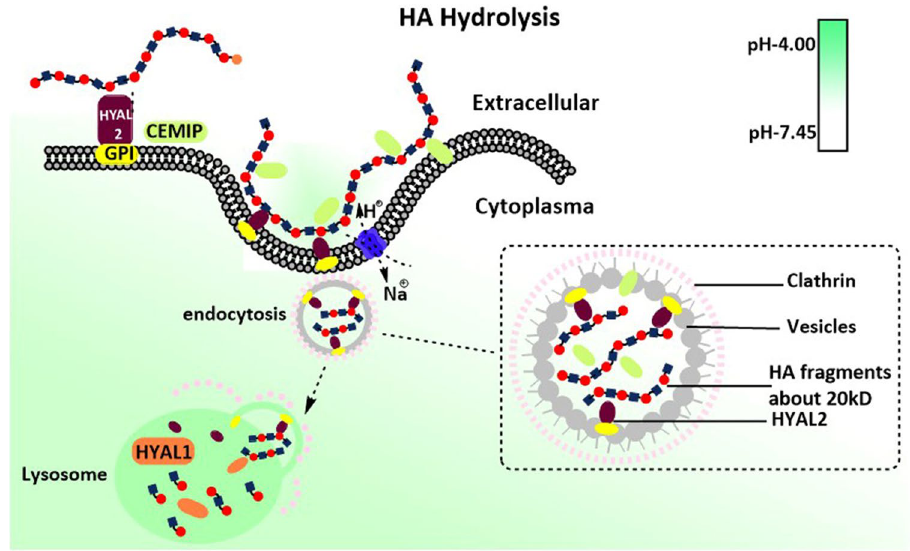
Fig. 3 The hydrolysis of HA. The two-step process of HA hydrolysis. The first step happens in the ECM, HA is caught by the membrane enzyme HYAL2, which is anchored by GPI and exposed to the external surface. Or like CEMIP, which attached membrane or secreted into ECM. HA and enzymes then form a complex to initiate the endocytosis process. And then, clathrin is recruited at the internal face of invagi- nation at the membrane. During this progression, Na + -H + ion pump promotes ion exchange for providing energy for endocytosis and adjusting local pH for optimum enzyme activity. HA is digested to LMW-HA (about 20kD) in vesicles, which are encapsulated by clathrin. After being delivered to the lysosome, endocytosis vesicles release content into the lysosome followed by enabling the second step. In the lysosome, HYAL1 take over the final process that cut off LMW-HA into smaller fragments or oligosaccharides. HYAL2 shows no more enzyme activity since the pH in lysosome let it inactivate. These oligosaccharides later may either enter the metabolic pathways or reassemble with UDP and be synthesized to HA